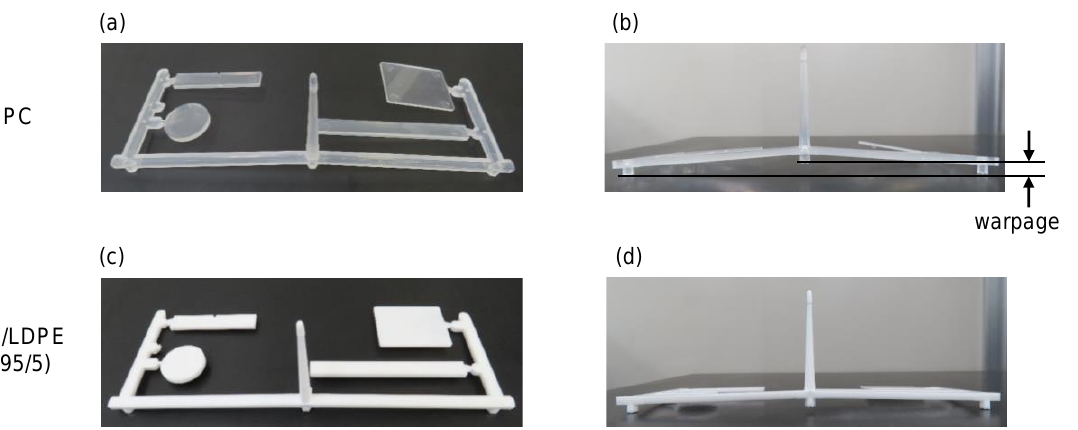
Figure 8. Injection-molded products of ( a , b ) PC and ( c , d ) PC/LDPE (95/5). Table 2. Injection pressures and warpage